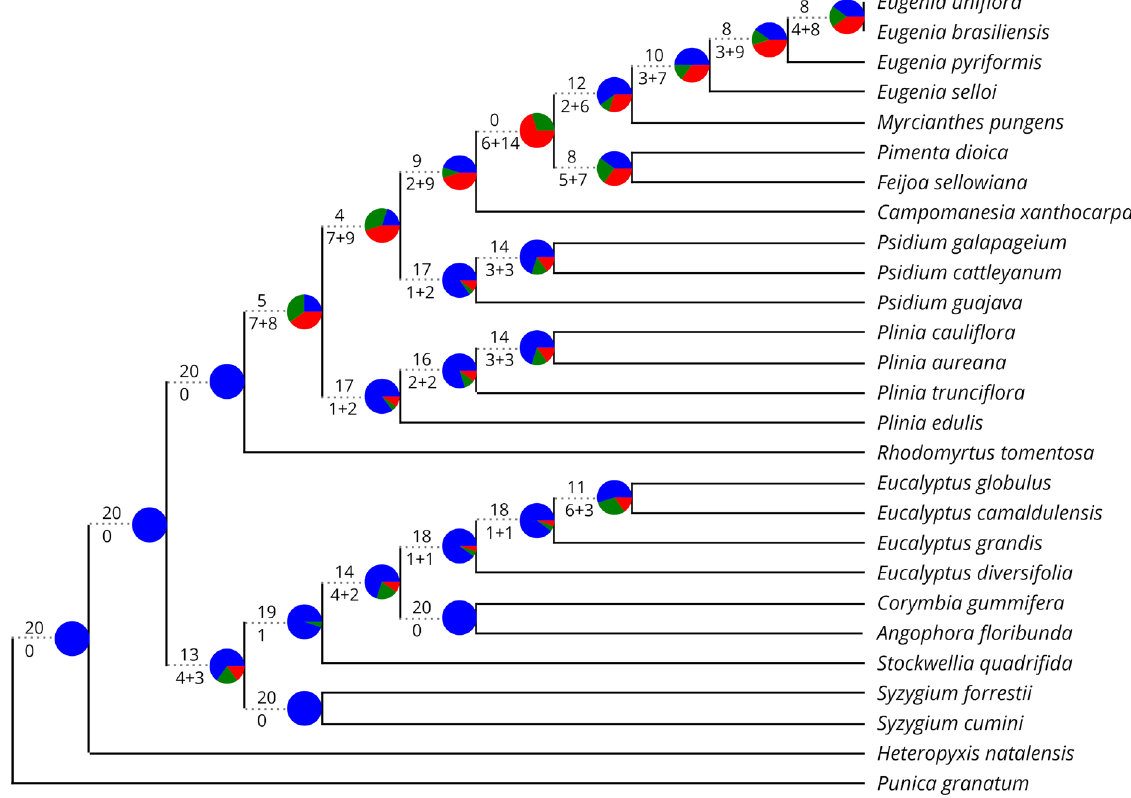
Figure 3 – Bipartition analysis of Myrtaceae phylogeny using the topologies generated individually by the 20 chloroplast protein-coding sequences against the topology of the. Pie charts and the numbers in the nodes represent the concordant (blue), discordant (red) and discordant prevalent alternative (green) bipartitions. Numbers above the branch correspond to the concordant bipartitions, and numbers under the branch represent the number of genes supporting a discordant prevalent bipartition + other discordant bipartitions. Information on number of tree topology and alignment data are present in Table 1 and Figure